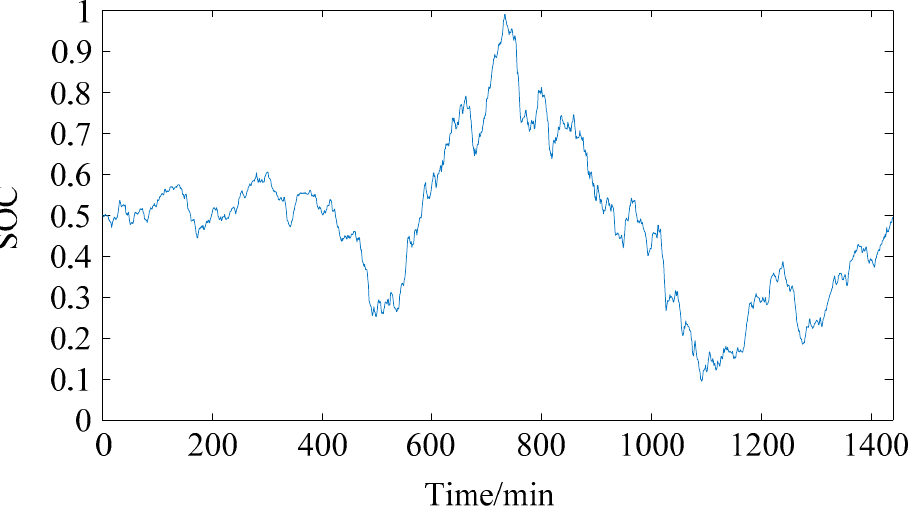
Figure 11. State of charge (SOC) of energy storage battery in scenario 2.